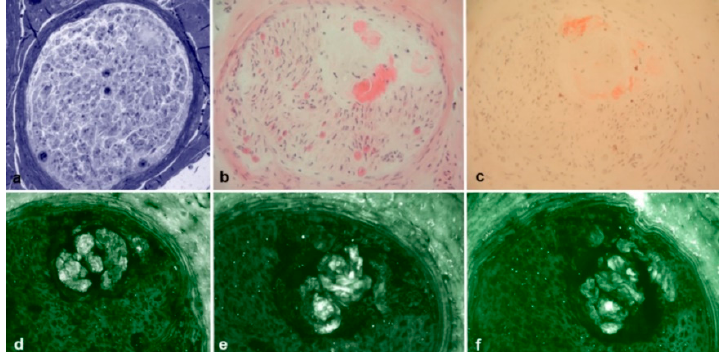
Figure 7. Sural nerve biopsy from a 76-year-old Val30Met hATTR patient. Semithin section stained with Toluidine blue ( a ) showed amyloid deposition confirmed also by H&E ( b ) and Congo red ( c ) staining. However, immunofluorescence with anti-TTR ( d ), anti-kappa light chain ( e ), and anti-lambda light chain ( f ) resulted not specific for TTR amyloidosis. No MGUS was detected in this patient.